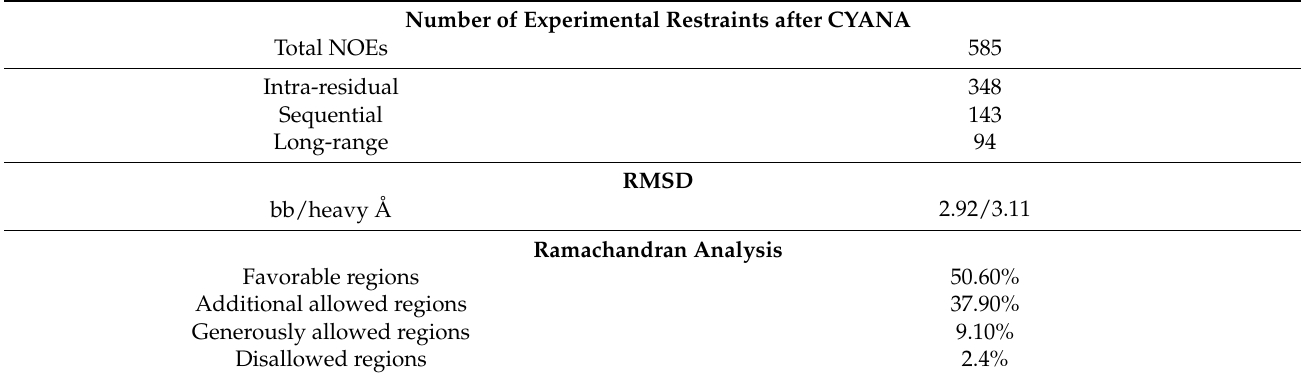
Table 1. Statistics for the structural calculation of the NMR ensemble of A β (1–42) peptide.